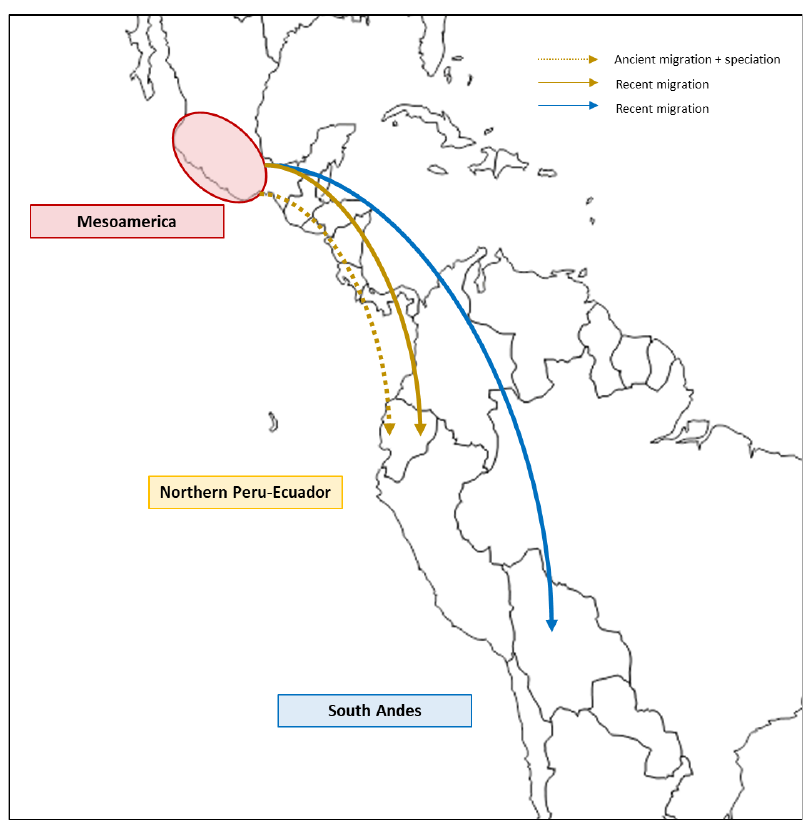
Figure 2. Graphical representation of the two different evolutionary hypotheses for wild P. vulgaris migration in America.